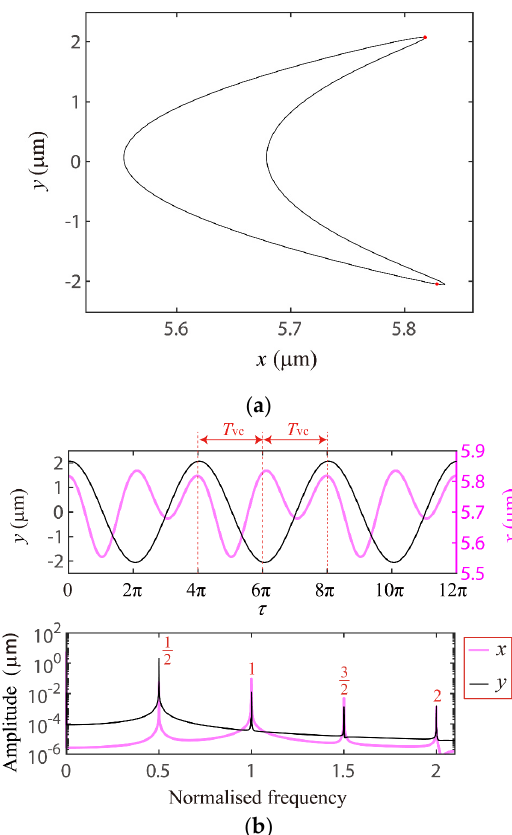
Figure 4. For δ 0 = 1.5 μ m, response characteristics of the VC period-1 motion when Ω = 310 rad/s, ( a ) orbit (black line) and its Poincare mapping (red dots), ( b ) time series and their frequency spectra.